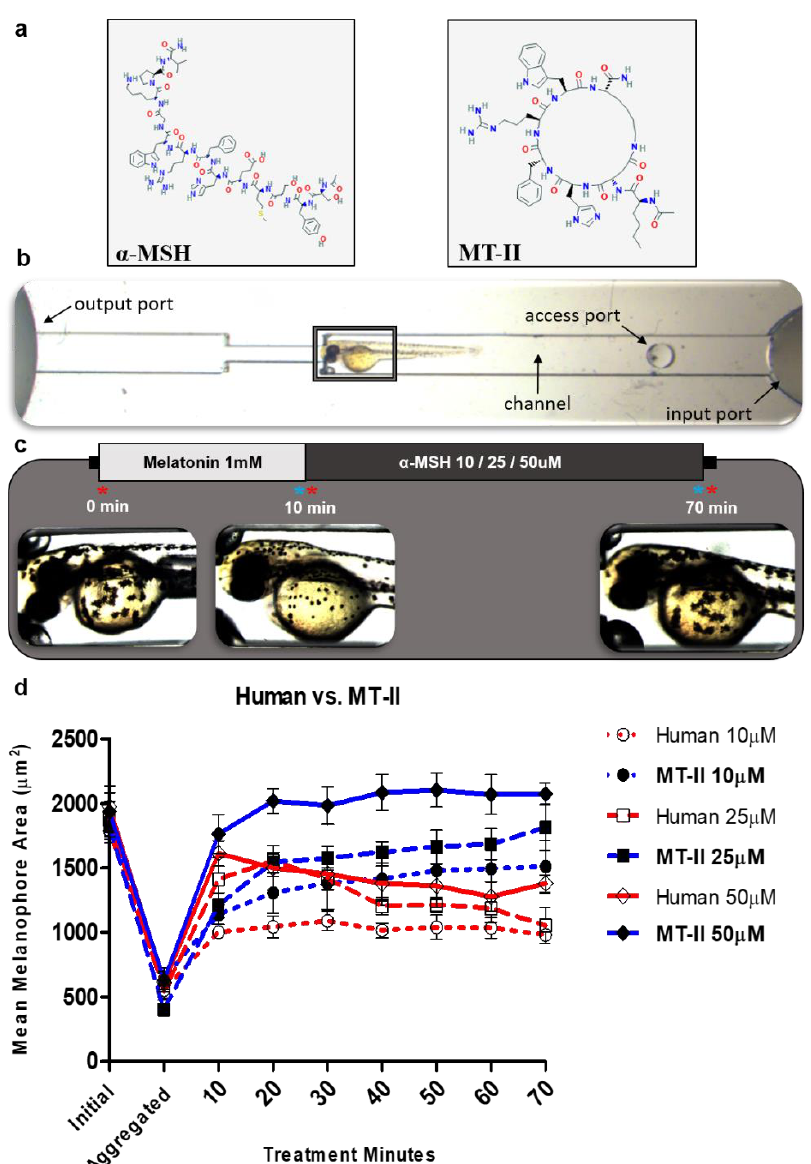
Figure 5. Melanophore restriction array assay comparing human α -MSH and MT-II. ( a ) Diagram representing the two-dimensional structure of α -MSH and MT-II. ( b ) Image of ZEBRA (zebrafish restriction array) device with major structural features labeled. The gray box indicates the region of magnification at imaging steps. ( c ) Protocol of melanophore restriction array assay. Red asterisks indicate imaging timepoints, while blue asterisks indicate timepoints for washing. ( d ) Curve shows the change of mean melanophore area over the treatment time for each peptide and concentration. Each curve aggregates the average of three trials ( n = 40–50 melanophores from 4–5 larvae for each trial). Data represents mean ±